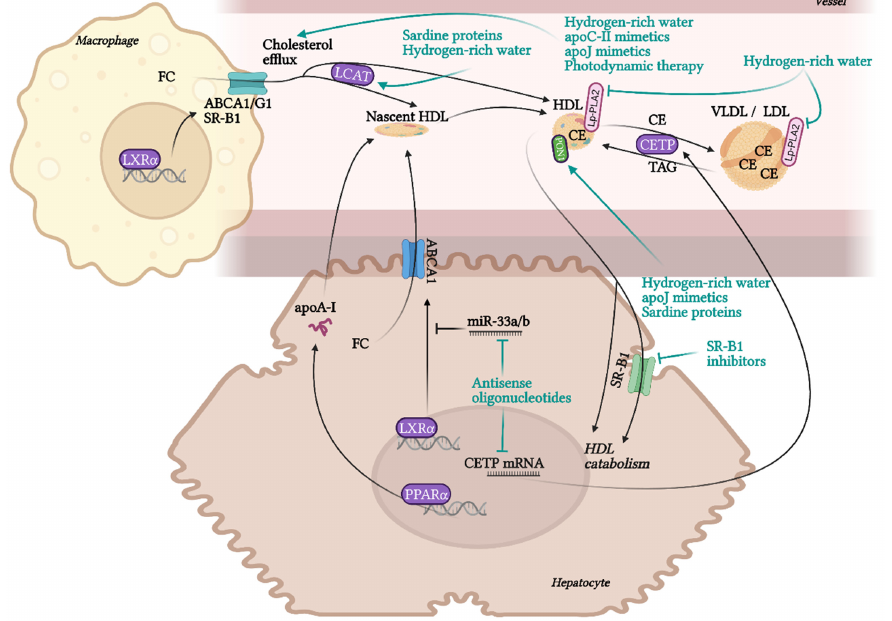
Figure 3. Simplified schematic representation of HDL-targeted therapies: Experimental drugs. Apolipoprotein A-I (apoA-I); ATP-binding Cassette Receptor A1 (ABCA1); ATP-binding cassette receptor A1/G1 (ABCA1/G1); Cholesterol ester (CE); Cholesteryl ester transfer protein (CETP); Free Cholesterol (FC); Free Fatty Acids (FFAs); Hepatic scavenger receptor B1 (SR-B1); Lecithin-Cholesterol Acyltransferase (LCAT); Lipoprotein-associated phospholipase A2 (Lp-PLA2); Liver X Receptor α (LXR α ); Paraoxonase 1 (PON1); Perixosome Proliferator-Activated Receptor α (PPAR α ); Triacylglycerols (TAG). Created with BioRender.com (accessed on 15 September 2022).